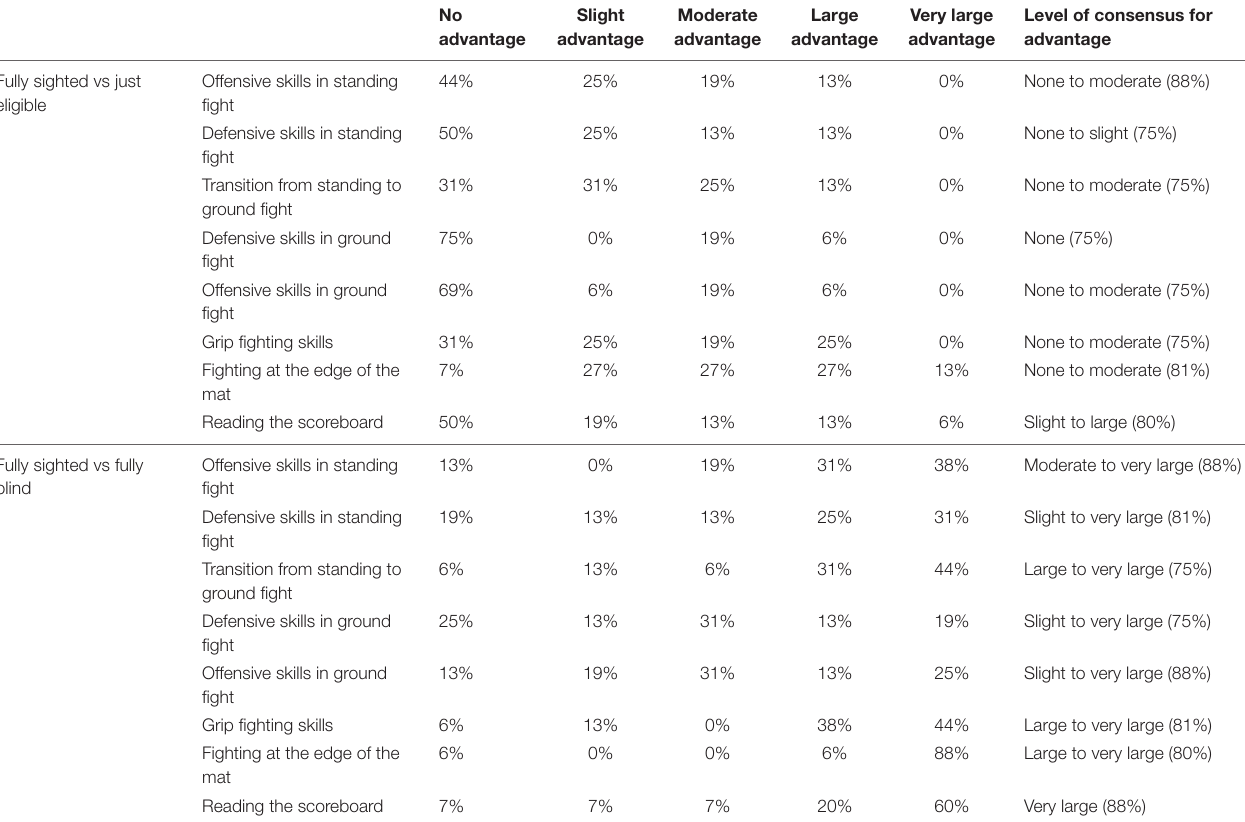
TABLE 5 | Impact of vision impairment on different aspects of judo